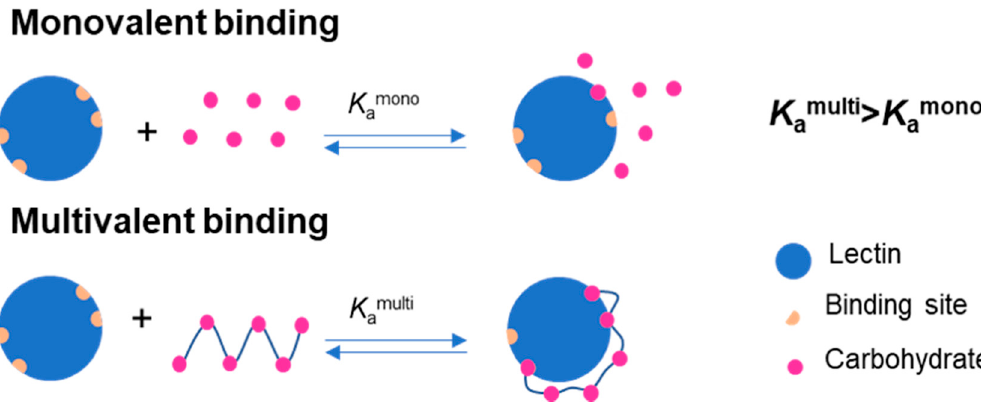
Figure 1. Schematic representation of the binding between lectins and one carbohydrate (monovalent binding) or two or more carbohydrates (multivalent binding).